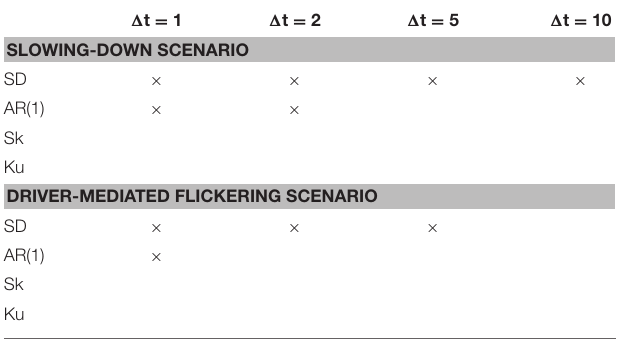
TABLE 2 | Summary of the robustness of EWSs to data aggregation for the two scenarios according to significance of Kendall Tau using the block-based